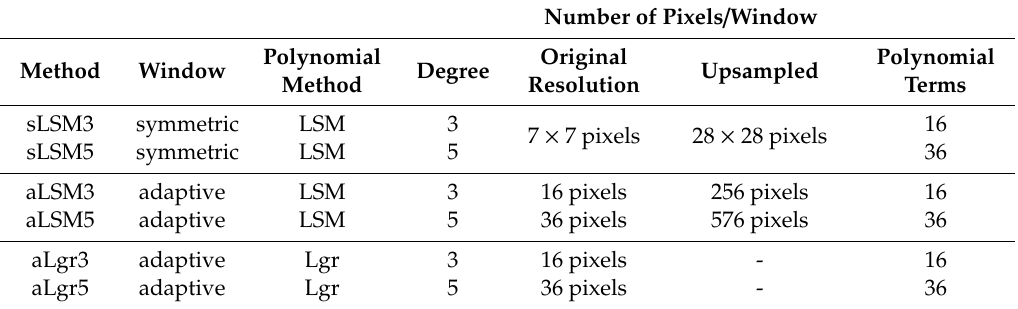
Table 2. The main characteristics of the sub-pixel methodological solutions analysed. The last two correspond to the proposed